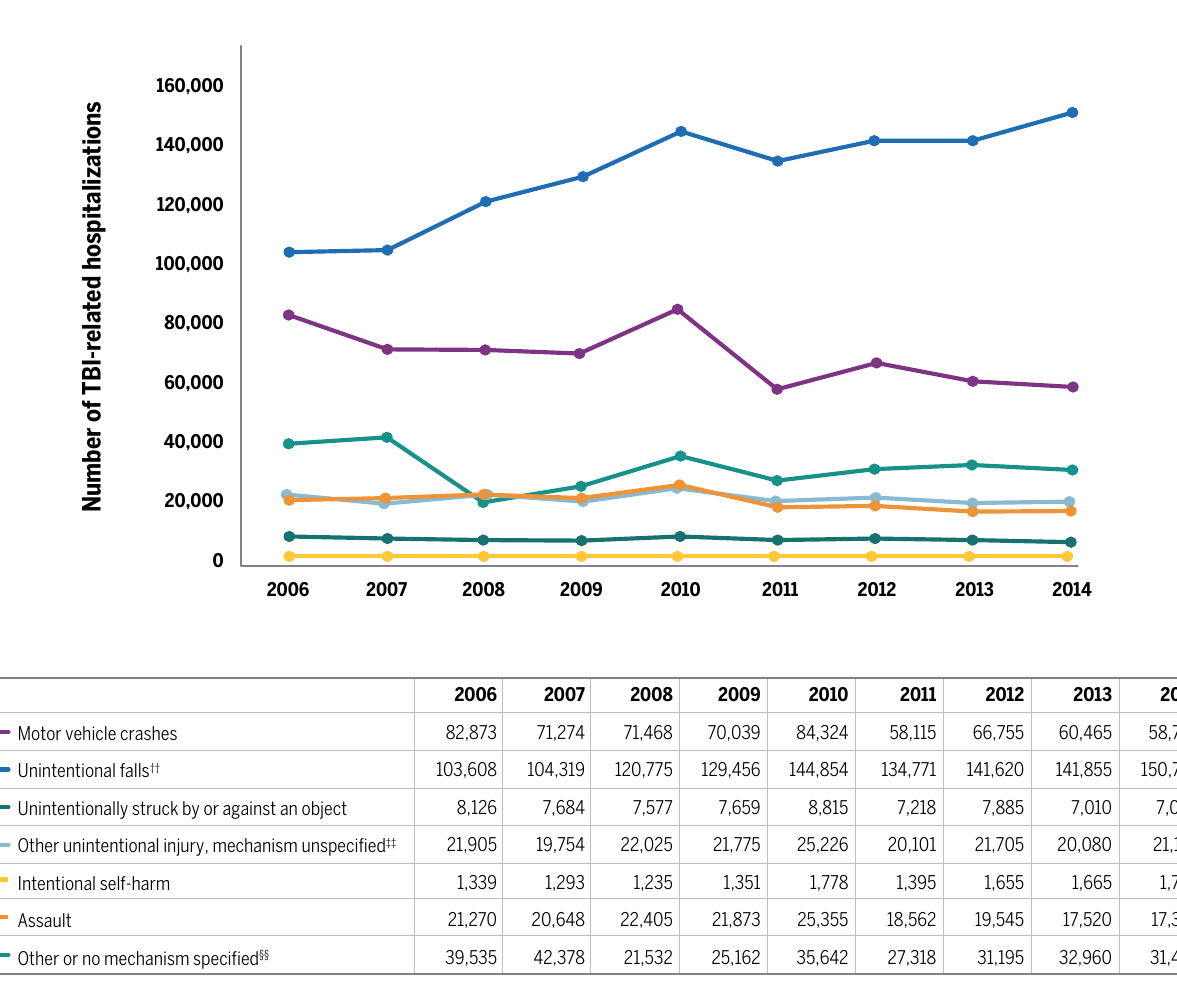
FIGURE 3B: ESTIMATED NUMBER OF TRAUMATIC BRAIN INJURY–RELATED HOSPITALIZATIONS‡, BY YEAR AND MECHANISM OF INJURY,